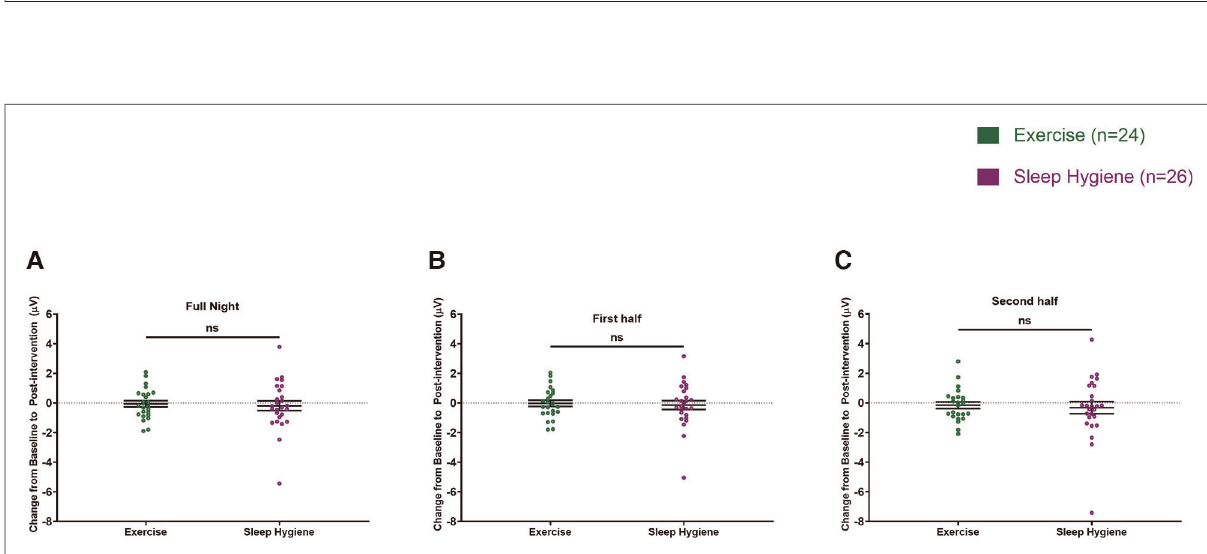
FIGURE 3 Spindle amplitude was not different between the two groups throughout the night ( A ), the fi rst half of the sleep ( B ), or the second half of the sleep ( C ). In all panels, the fi gures are scatter plots, and error bars represent the mean and standard error of mean. ns: not signi fi